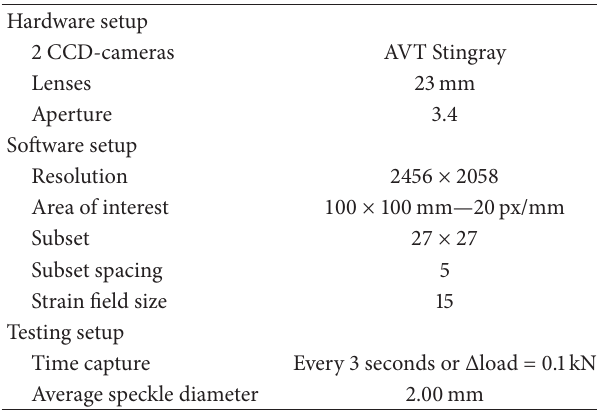
Table 1: DIC test set-up